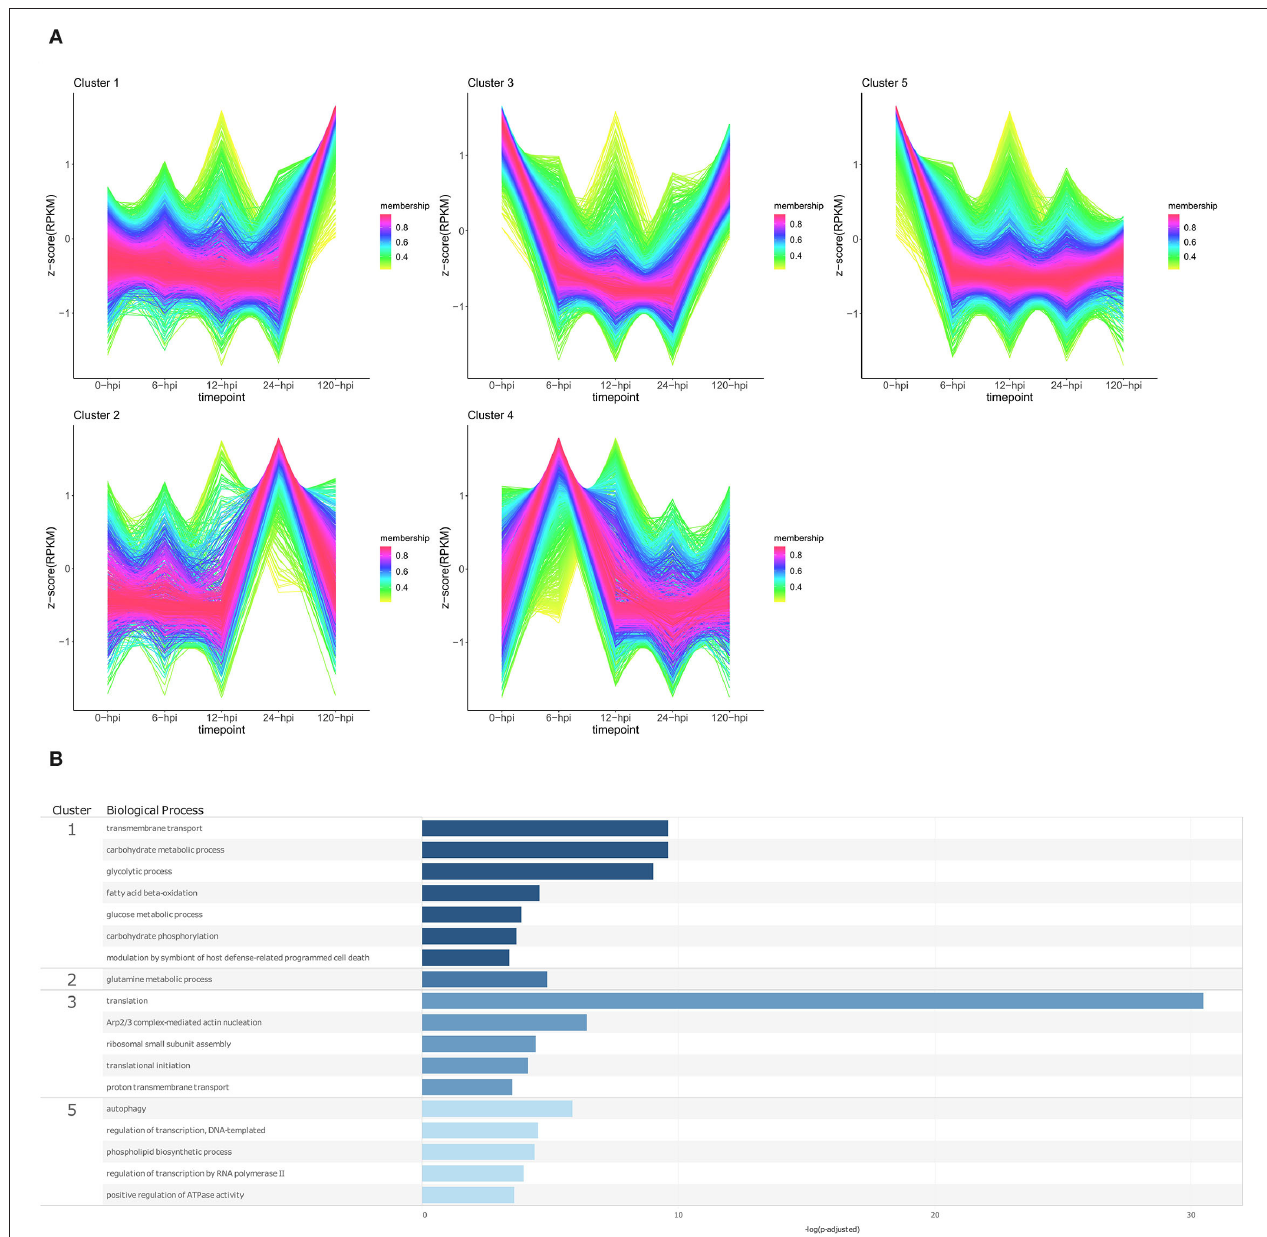
FIGURE 6 | Temporal clustering and Gene Ontology enrichment of Phytophthora cinnamomi differentially expressed genes (DEGs) following inoculation of the Persea americana rootstock Dusa ® . (A) Sample libraries from in vitro mycelial controls and the partially resistant P. americana rootstock Dusa ® inoculated with P. cinnamomi were used in clustering analyses. DEG Z-scores, based on reads per kilobase million (RPKM) normalized read counts, were calculated and used for clustering analyses using the fuzzy c-means (Futschik and Carlisle, 2005) in the R package TCseqv1.16.0 (Wu and Gu, 2021). Inoculated samples included 6, 12, 24, and 120h post inoculation (hpi) and are indicated on the x-axis, with the mock-inoculated samples indicated as 0 hpi. Membership scores produced by the fuzzy c-means algorithm are color-coded and indicated to the right of each cluster. (B) Member genes from each cluster were subjected to Gene Ontology (GO) enrichment and significantly overrepresented GO terms, with adjusted p -value < 0.05 Benjamini-Hochberg false discovery rate, were reduced in REVIGO (Supek et al., 2011). The cluster from which the terms originate is indicated on the left most side of the Figure, followed by the biological process GO term. The overrepresented p -value of each GO term is indicated along the x-axis as –log 10 ( p